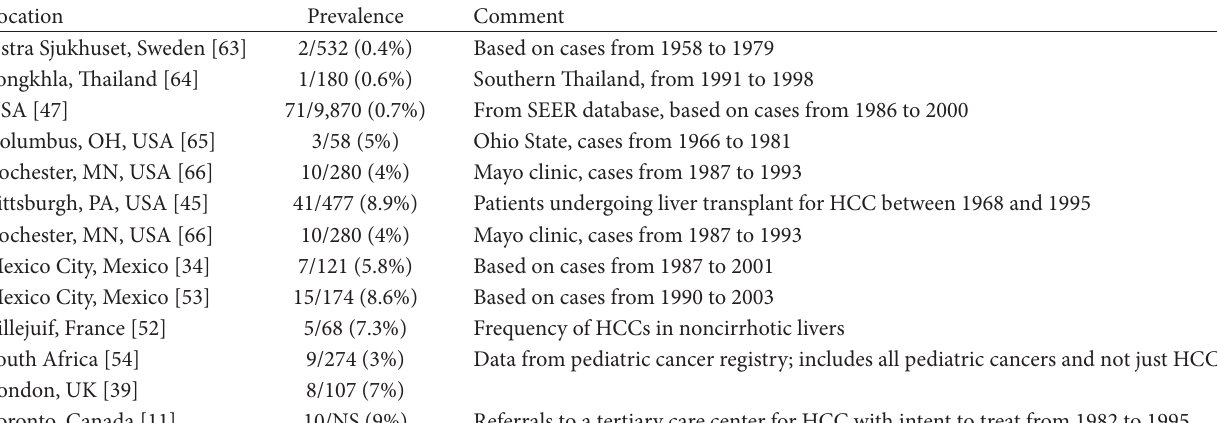
T 2: Representative studies of the prevalence of FLC in various populations.